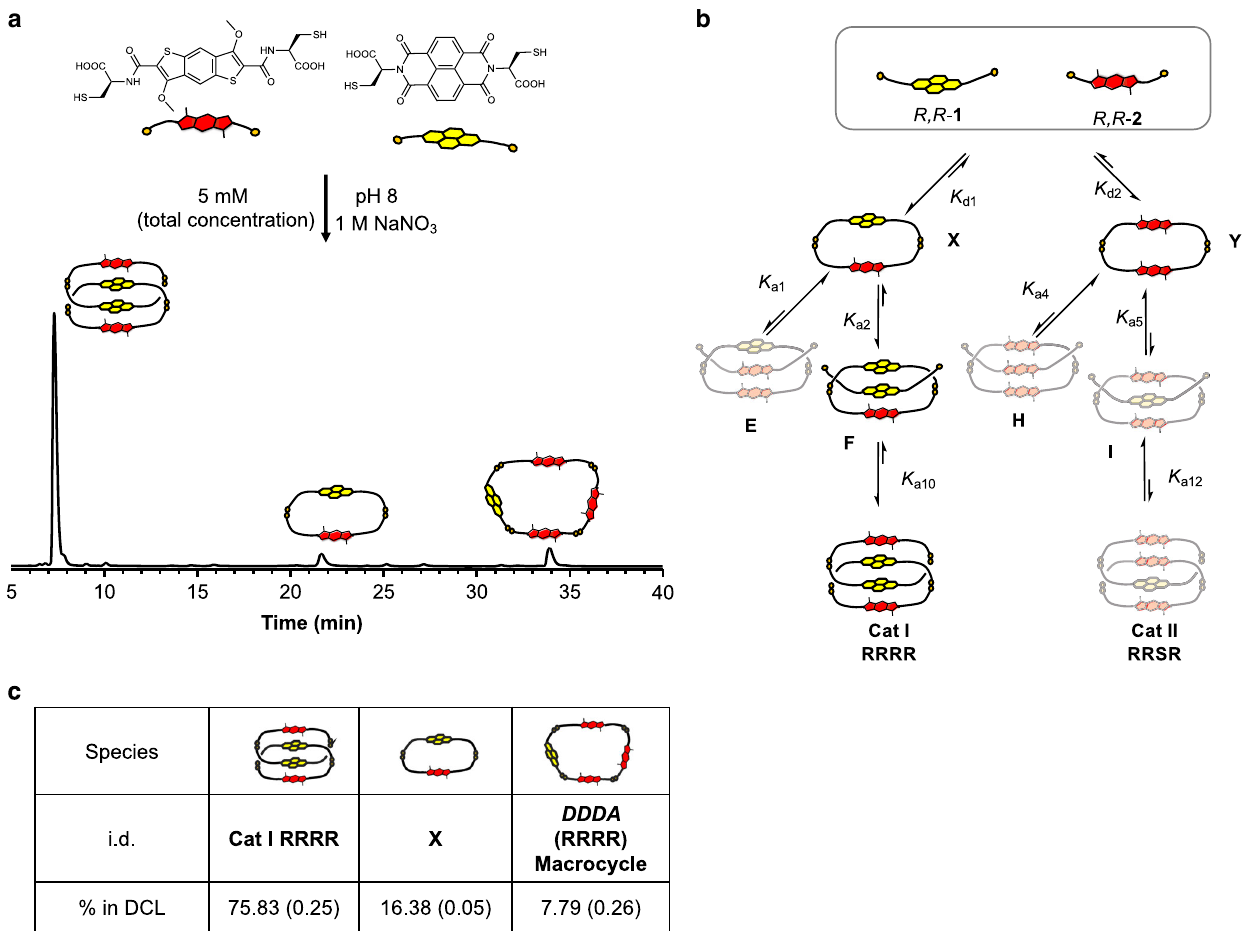
Fig. 2 Homochiral DCL. a Reverse-phase HPLC analysis at 389 nm of R,R - 1 : R,R - 2 (1:1 molar ratio, 5 mM total concentration) library in the presence of 1 M NaNO 3 ; b schematic representation of equilibria showing the pathway for the formation of Cat I RRRR and c table containing the yields for each species in DCL; the integrations were done in triplicate and the RMSD is reported in parenthesis along with the